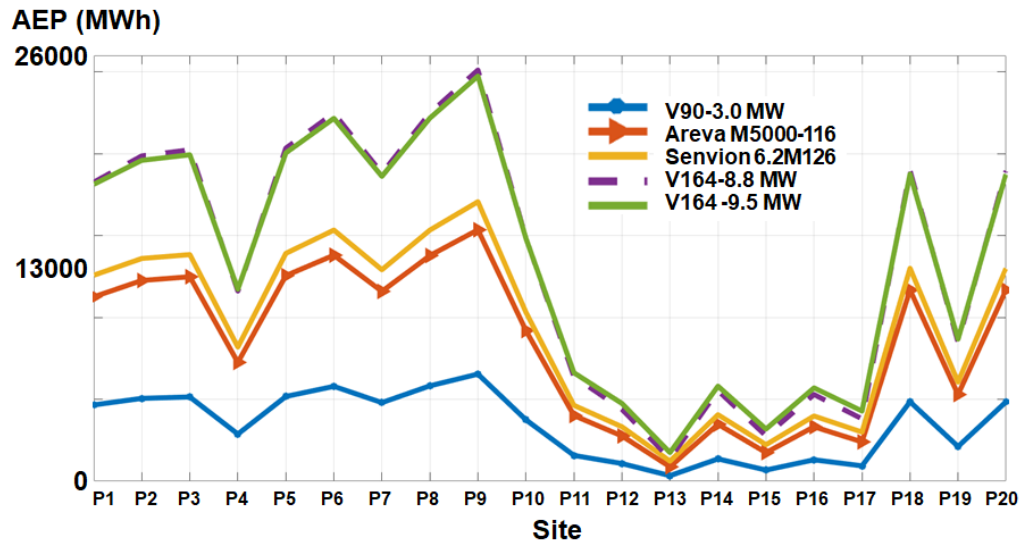
Figure 9. Annual Energy Production (AEP in MWh) of the offshore wind turbines.